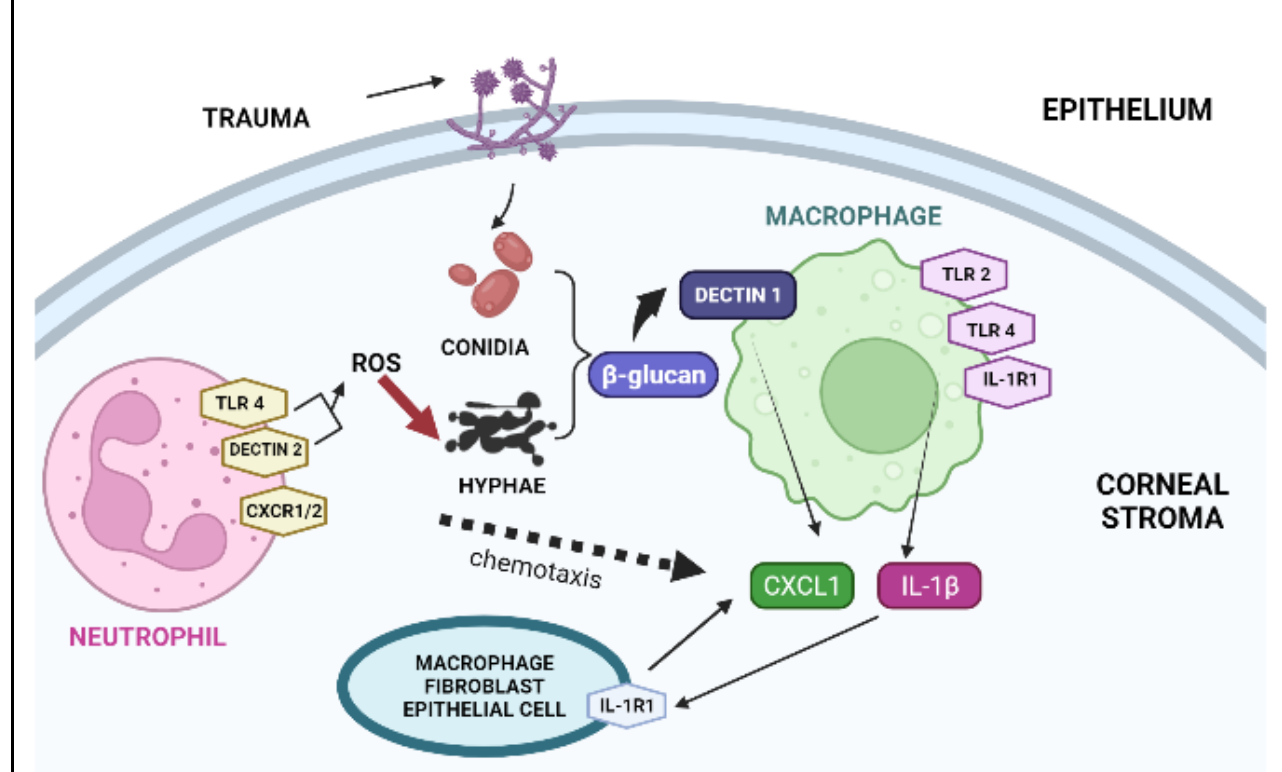
Figure 1. Corneal inflammatory sequences that occur in fungal keratitis. Injury to the corneal stroma encourages the inoculation of fungal conidia, which then germinate upon contact with β -glucan. Furthermore , β -glucan is detected by dectin-1 on macrophages that transcribe CXCL1 and IL- 1β mRNA after a sequence of events. Upregulated CXC chemokines recruit neutrophils to the cornea, which stimulate ROS, resulting in fungal death. Abbreviations: TLR, Toll-like receptor; ROS, reactive oxygen species; IL, interleukin; CXCL-1, keratinocytes-derived